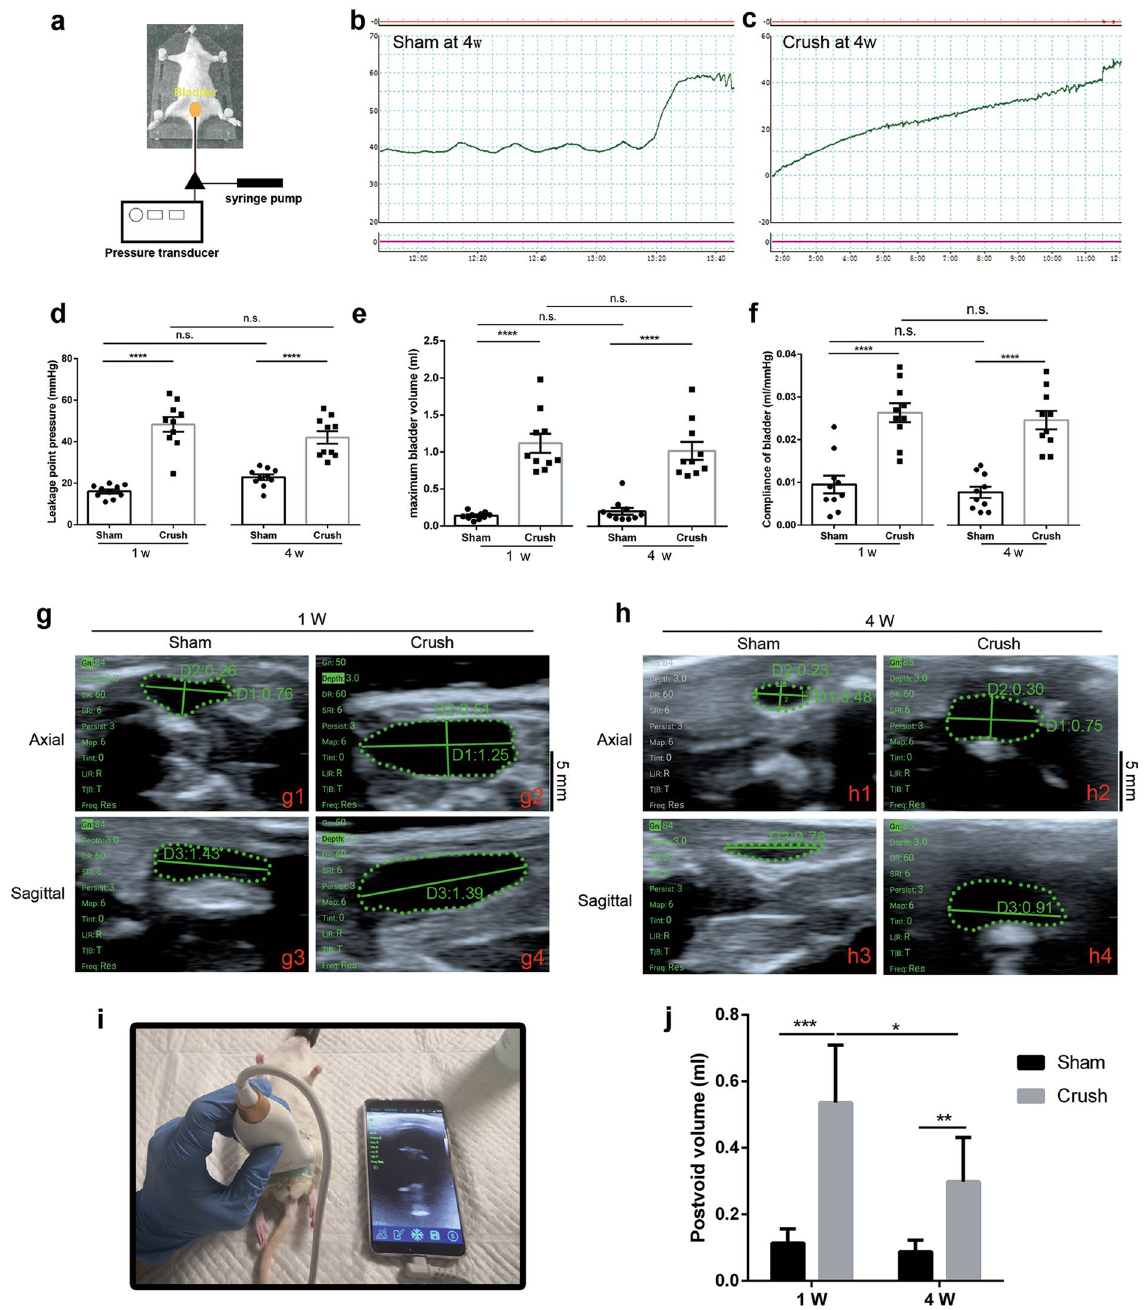
Figure 3. Results of urodynamic test and ultrasound examination at 1 week and 4 weeks. ( a ) Illustration image of urodynamic test procedure. ( b and c ) P–T curve of urodynamic test at 4 w. ( d - f ) Leakage point pressure, maximum bladder volume and compliance of bladder in two groups 1 week and 4 weeks after injury. N = 10/ group. ( g and h ) Ultrasound axial and sagittal image of bladder in two groups at 1 w and 4 w. Ultrasound test was performed to measure bladder width and depth at axial position, length was measured at sagittal position. Scale bar: 0.5 cm. ( i ) Image of the ultrasound procedure of rats. A 2 – 10 MHz linear array transducer was used to measure bladder volumes of rats in two groups under isoflurane anesthesia. ( j ) Postvoid volume calculated from ultrasonography at 1 w and 4 w. Data of d - g was represented as mean ± SEM. Significance levels were set